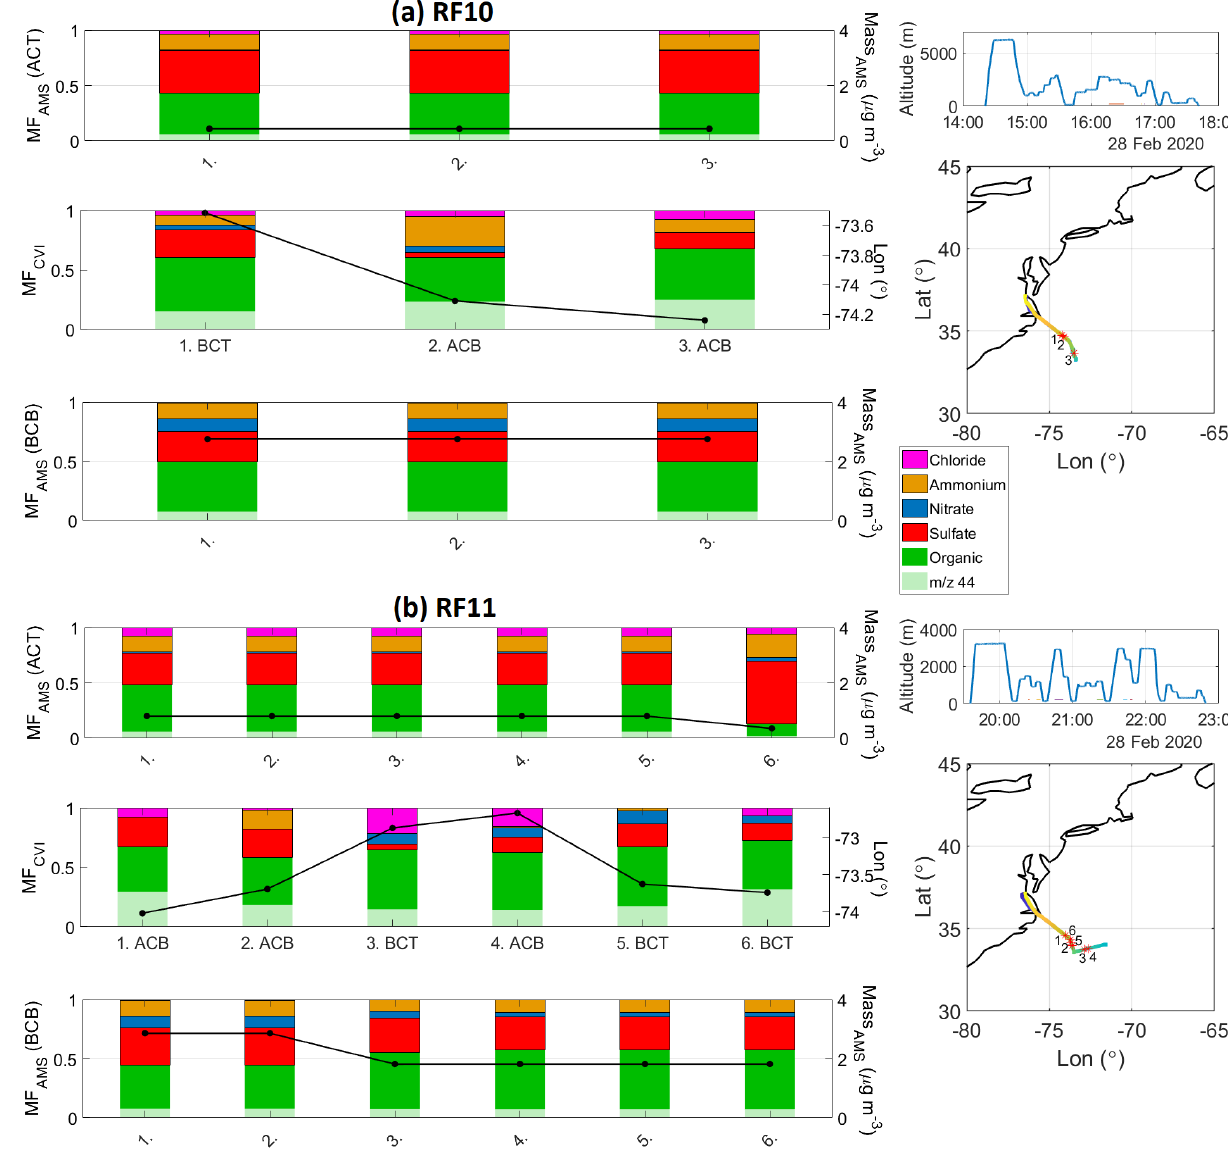
Figure 11. Summary of AMS composition in adjacent BCB, cloud, and ACT legs during back-to-back flights (research flights 10 and 11) in cold air outbreak conditions on 28 February 2020. Shown in the bar charts are the mass fractions of AMS components in addition to either total AMS mass (for ACT and BCB legs; such data are not robust for CVI legs due to how the CVI operates) or longitude on the right y axis. Note that some BCB and ACT legs are repeated for different cloud legs as they represent the closest leg to an individual cloud leg. On the far right are flight altitude time series along with the spatial map with numbers corresponding to the leg numbers in the bar